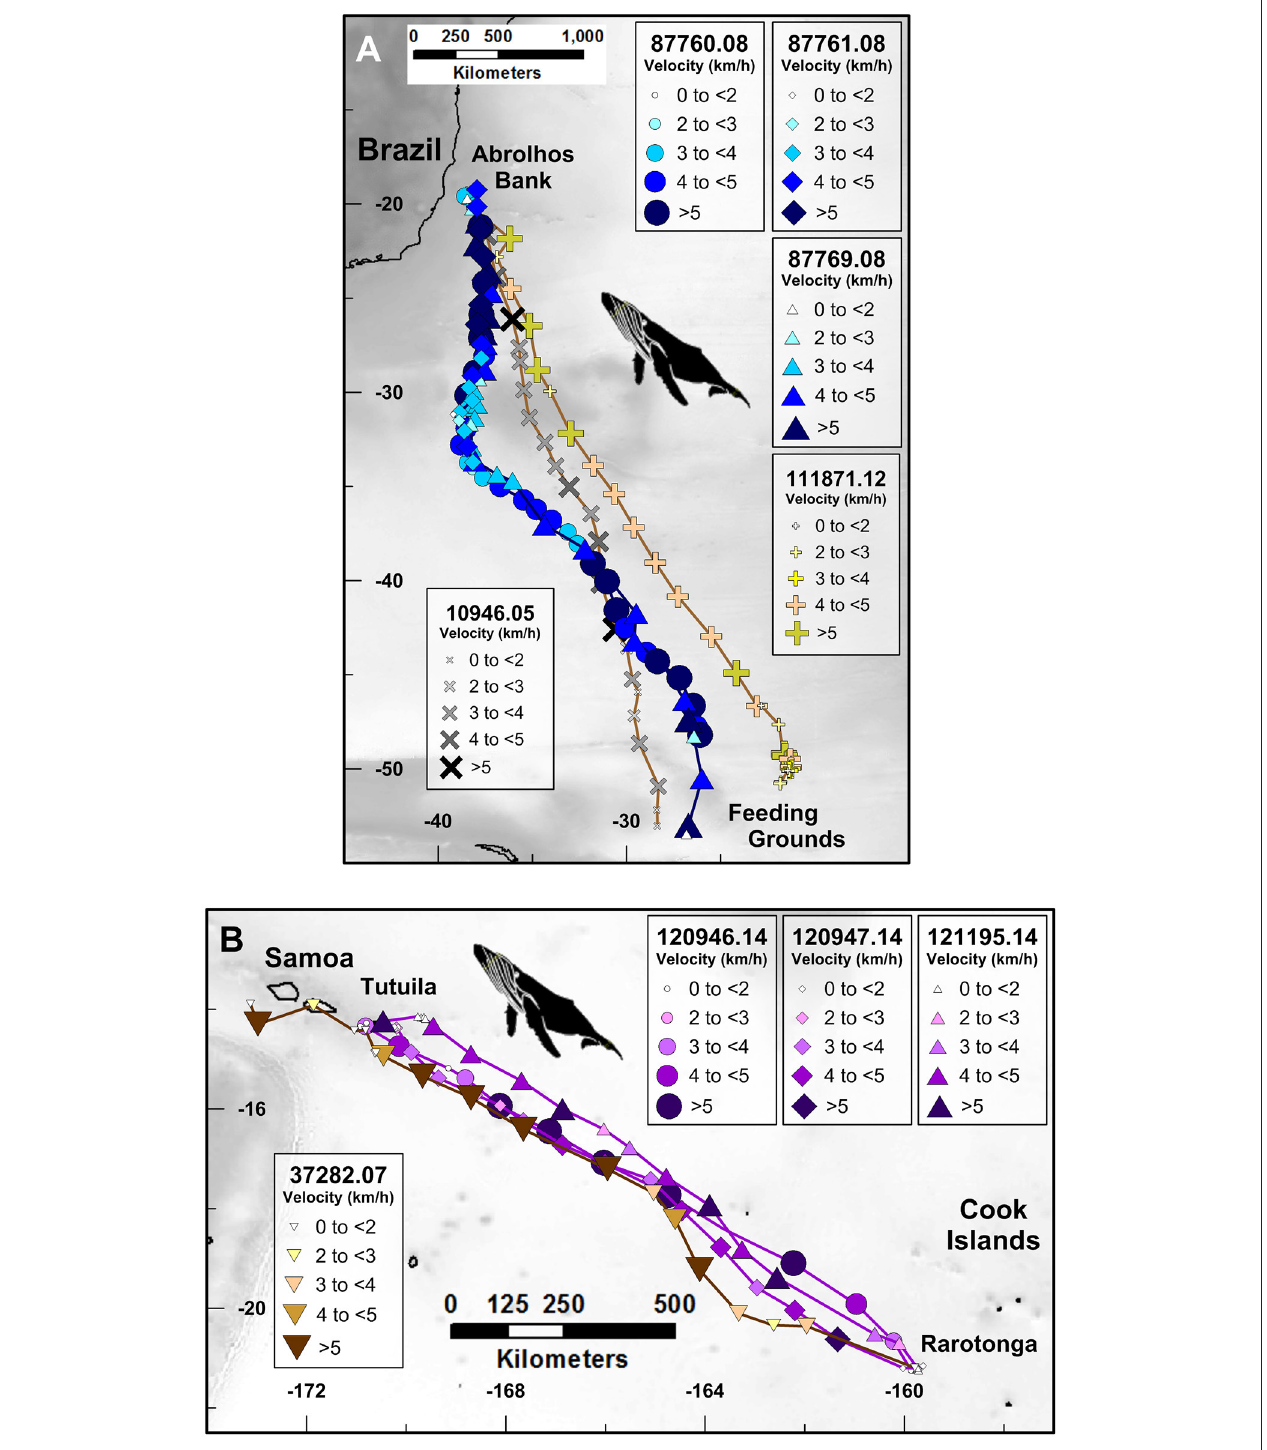
FIGURE 1 | Route fidelity and non-route fidelity movements of satellite-monitored humpback whales, including: (A) humpback whales in the South Atlantic Ocean, (B) humpback whales in the South Pacific Ocean. Symbol sizes and color hue correspond with average daily track velocity (km/h) as shown in the legends. Unique platform transmitting terminal (PTT) tag numbers to the left of the PTT number decimal point correspond with individual whales and are represented by symbol shape; digits to the right of PTT number decimal point correspond with the abbreviated year in which the whale was tagged and are represented by symbol color family (i.e., blue, yellow, purple, etc.). Multiplication (PTT 10946.05) and addition (PTT 111871.12) symbols in (A) correspond with long-distance non-route fidelity migrations.